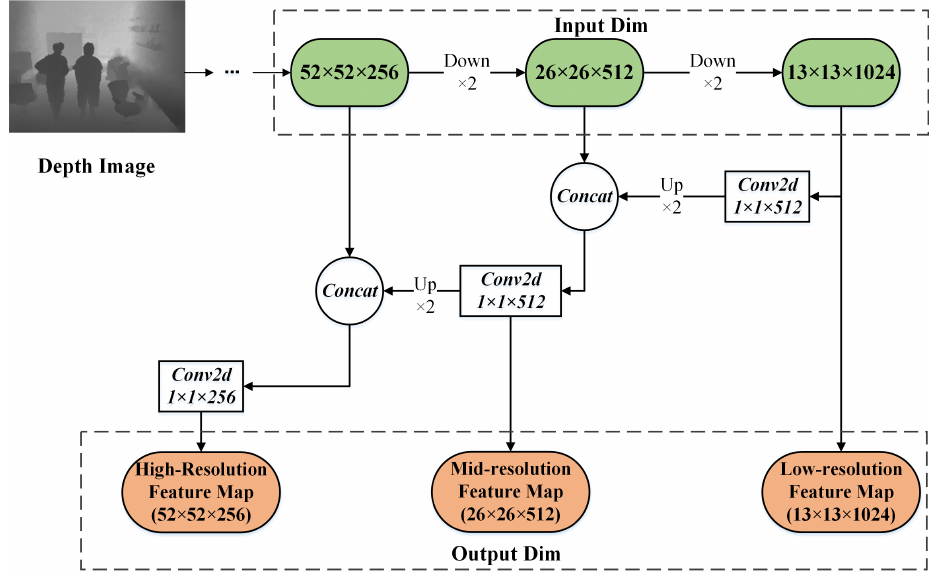
Figure 4. The structure of the